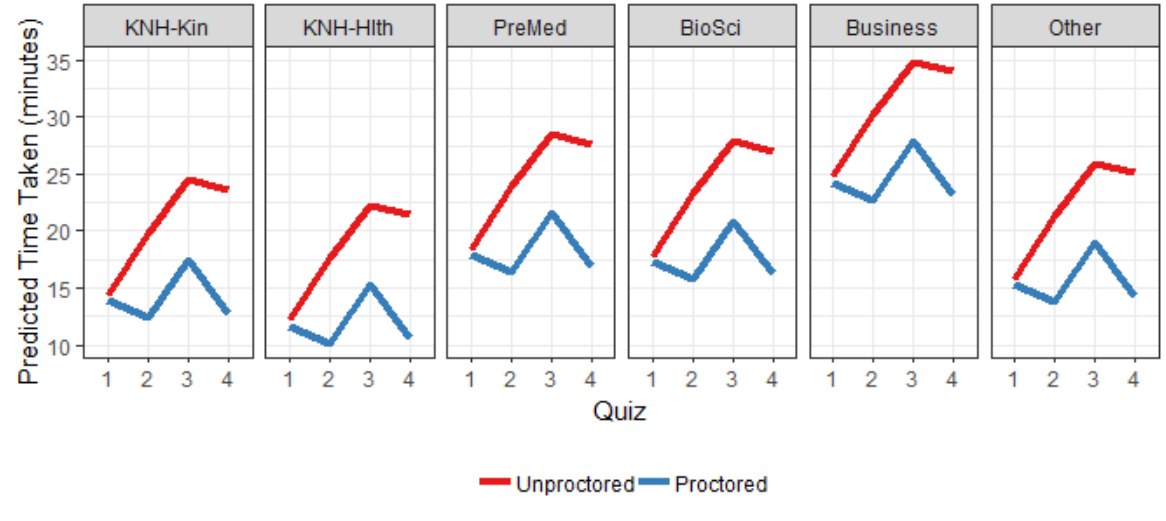
Figure 4 . Plot of predicted time to complete test under each combination of student major, quiz number, and proctoring status based on fixed effects structure from fitted